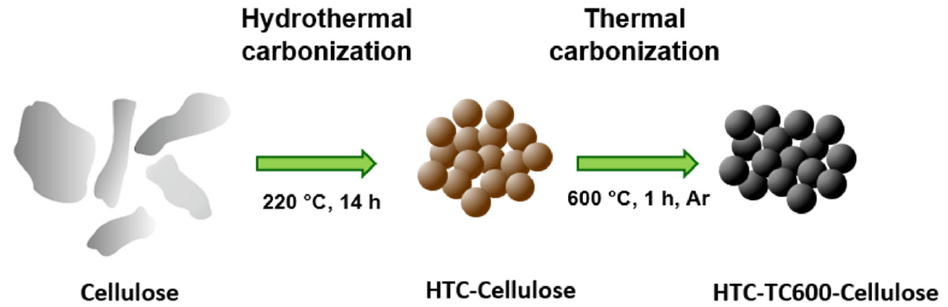
Figure 9. Illustration of the two-step carbonization process of cellulose particles utilizing consecutive hydrothermal and thermal carbonization.